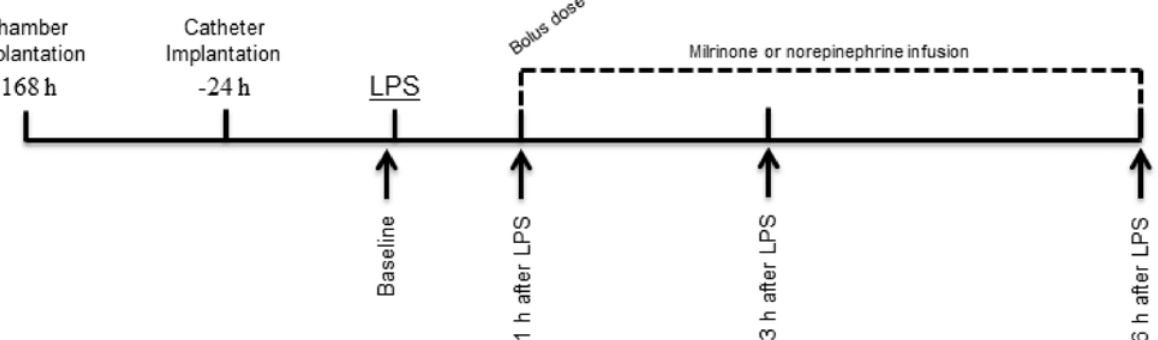
Fig 1. Schematic representation of the experimental protocol. After baseline determination of hemodynamic and microcirculatory parameters (Baseline) LPS was administrated. Sequential measurements were performed after one, three, and six hours of LPS injection (arrows). Blood sampling for biochemical and hematological analysis was performed in all groups at the end of the study period (6 h after